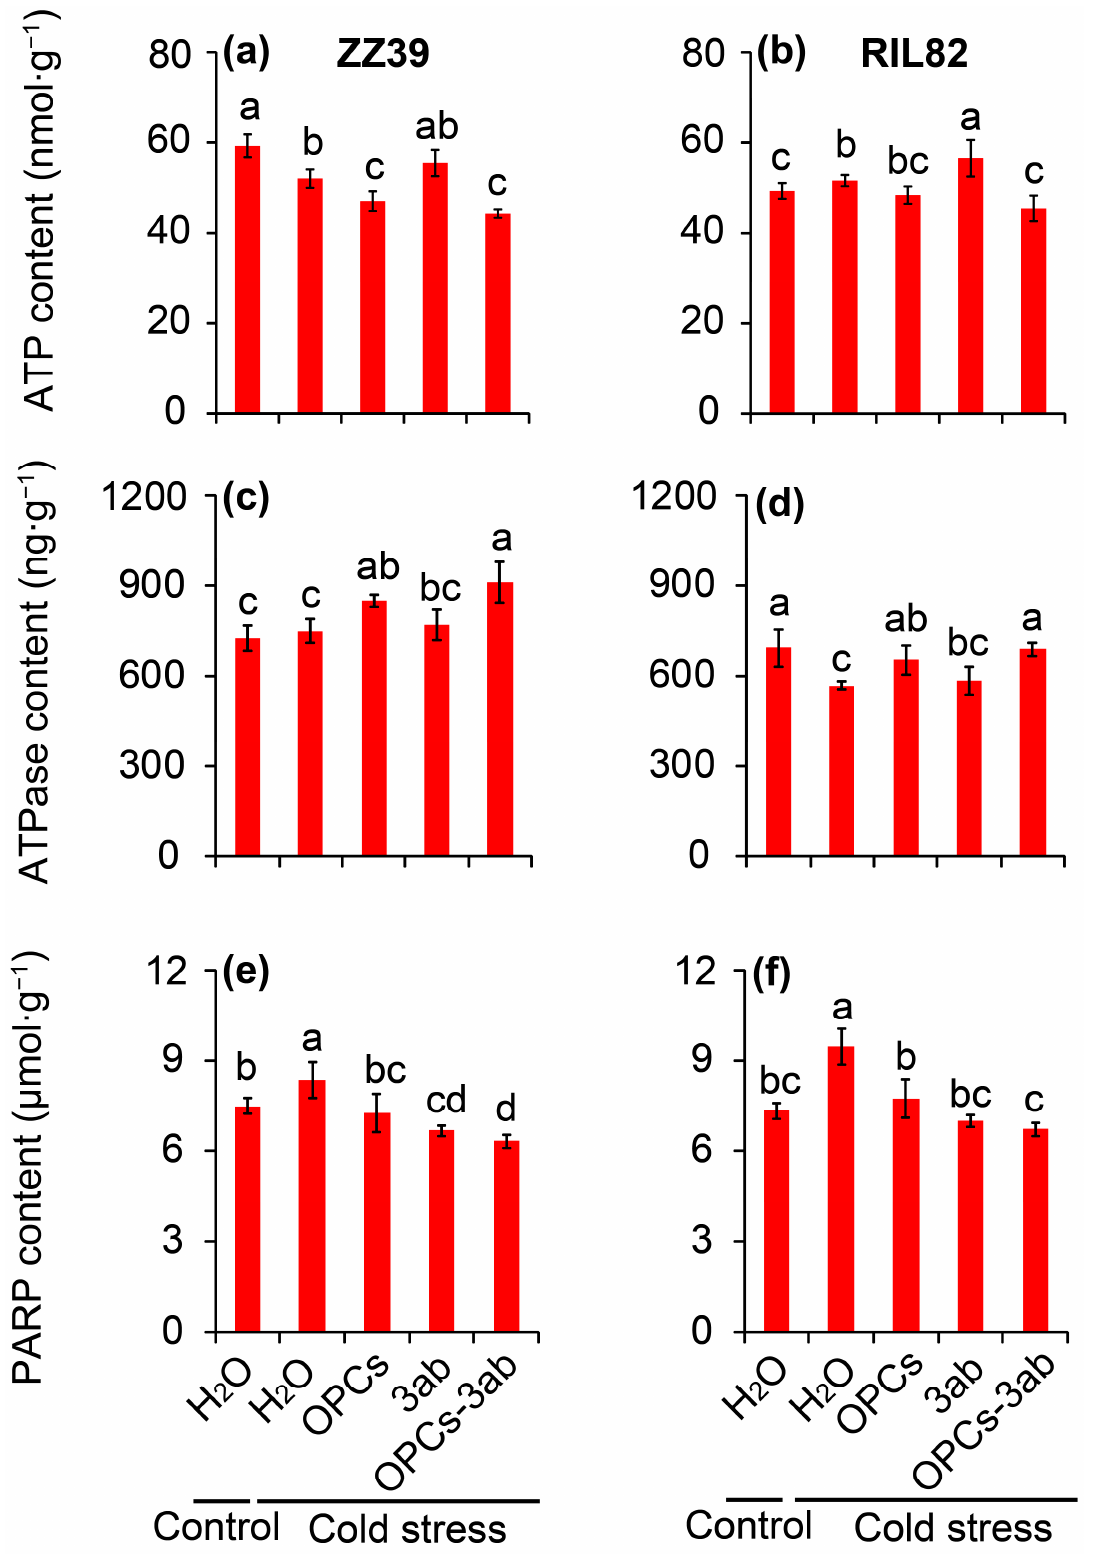
Figure 8. Effect of OPCs and 3ab on contents of ATP, ATPase, and PARP in rice leaves under cold stress. ( a , b ), ATP content; ( c , d ), ATPase content; ( e , f ), PARP content. OPCs, oligomeric proanthocyani- dins; 3ab, 3-aminobenzamide; PARP, poly (ADP-ribose) polymerase. Vertical bars denote standard deviations ( n = 3). Different letters indicate significant differences among the control and cold stress treatments within a genotype by two-way analysis of variance (temperature and treatment) ( p <